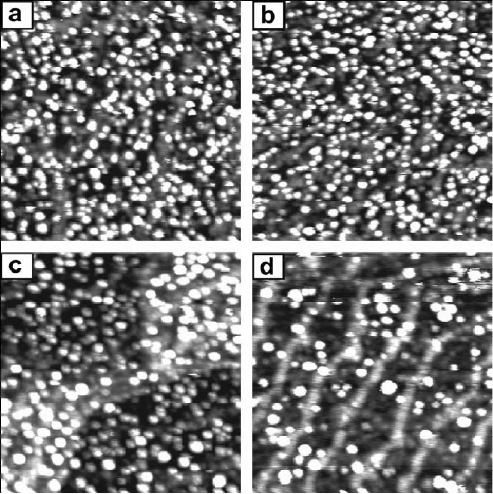
Fig. 14 – STM images (size 60 × 60 nm 2 , V S = 3 V, I = 0 . 1 nA) of 2.5Å niobia sample: (a) as prepared at 300 K; (b) flashed to 700 K in UHV; (c, d) flashed to 400 K (c) and then to 900 K (d) in 10 –7 mbar O 2 . Note smaller morphological changes for the oxidized samples as compared to the UHV annealed samples (see Fig. 7) (Uhl et al. 2007).